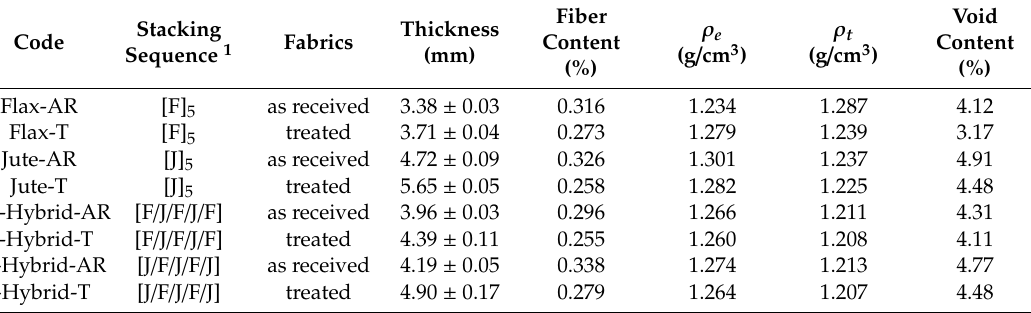
Table 1. List of manufactured composite